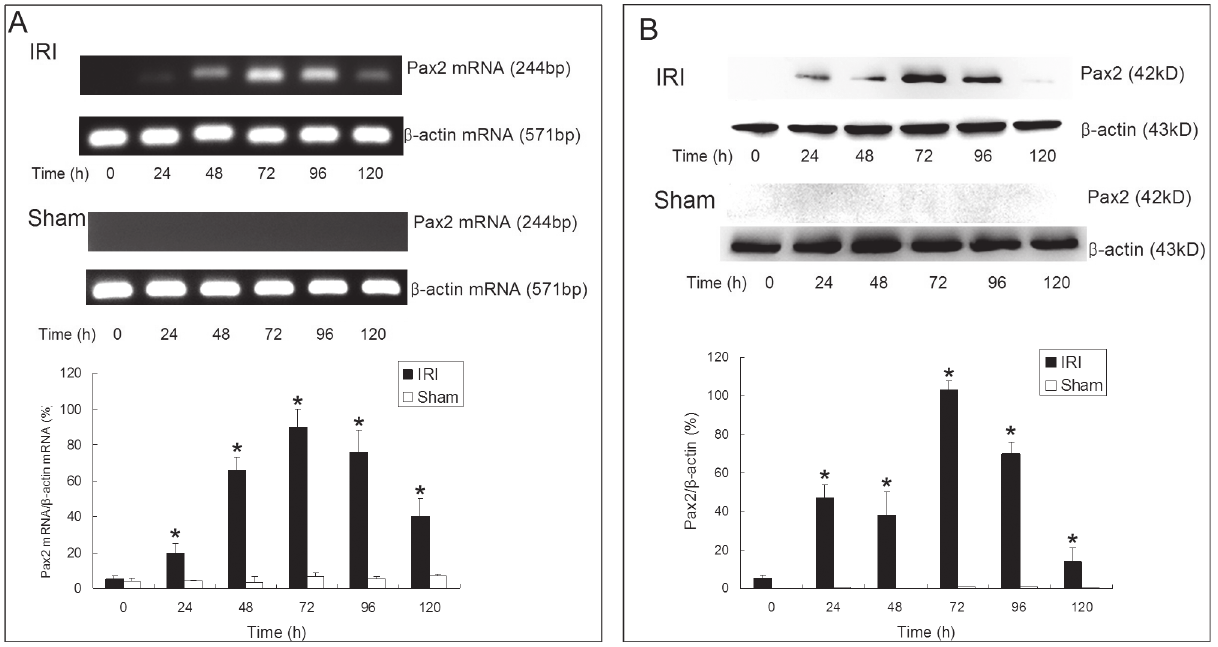
Fig 3. Pax2 expressions in renal cortex detected by RT-PCR and western blot. The mRNA (A) and protein (B) levels of Pax2 in renal cortex were detected via RT-PCR and western blot. Pax2 was expressed in the IRI groups 48 – 96 h after IRI operation ( * P < 0.05, IRI compared with sham), while Pax2 could not be detected in renal cortex of animals in sham-operation